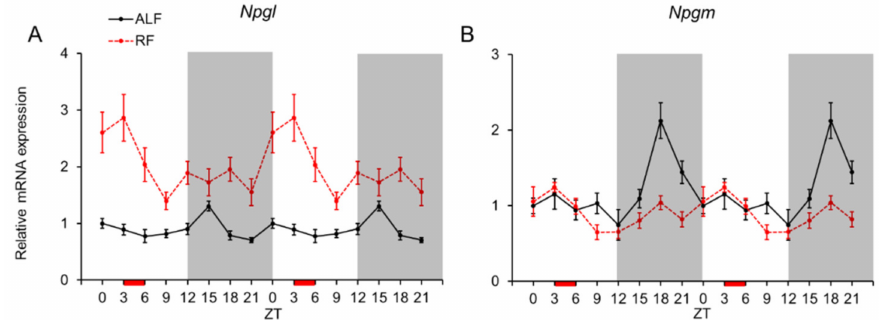
Figure 2. mRNA expression levels of the neurosecretory protein GL ( Npgl ) and neurosecretory protein GM ( Npgm ) genes in the mediobasal hypothalamus (MBH). Double-plotted graphs showing the mRNA expression levels of Npgl ( A ) and Npgm ( B ) under ad libitum feeding (ALF: Black lines) and time-restricted feeding (RF: Red lines) schedules. Data are expressed as the mean ± standard error of the mean, n = 5–6 mice per datum